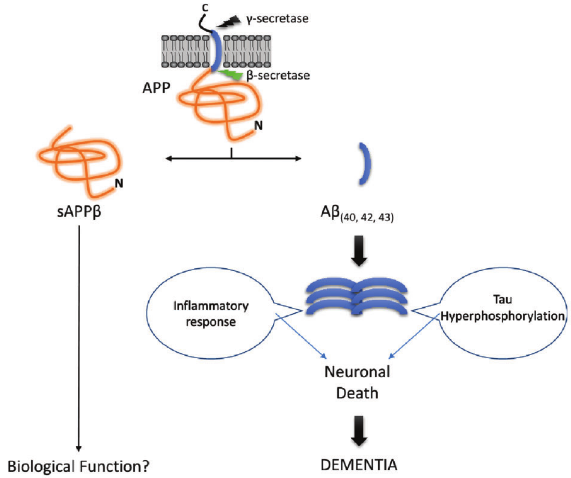
Figure 1. Alzheimer’s disease (AD) in its molecular aspects. AD presents two characterized pathological markers: b -amyloid (A b ) plaques and neurofibrillary tangles. The b -cleavage of the amyloid precursor protein (APP) results in a soluble form of this protein (sAPP b ). The b -cleavage followed by a c -cleavage of the precursor protein results in an insoluble form of A b peptides, which aggregate and form plaques, causing an inflammatory response that leads to neuronal death and symptoms of dementia. The neurofibrillary tangles are formed by hyperphos- phorylation of the Tau protein, which plays a role in inducing A b toxicity as well as mitochondrial dysfunction in